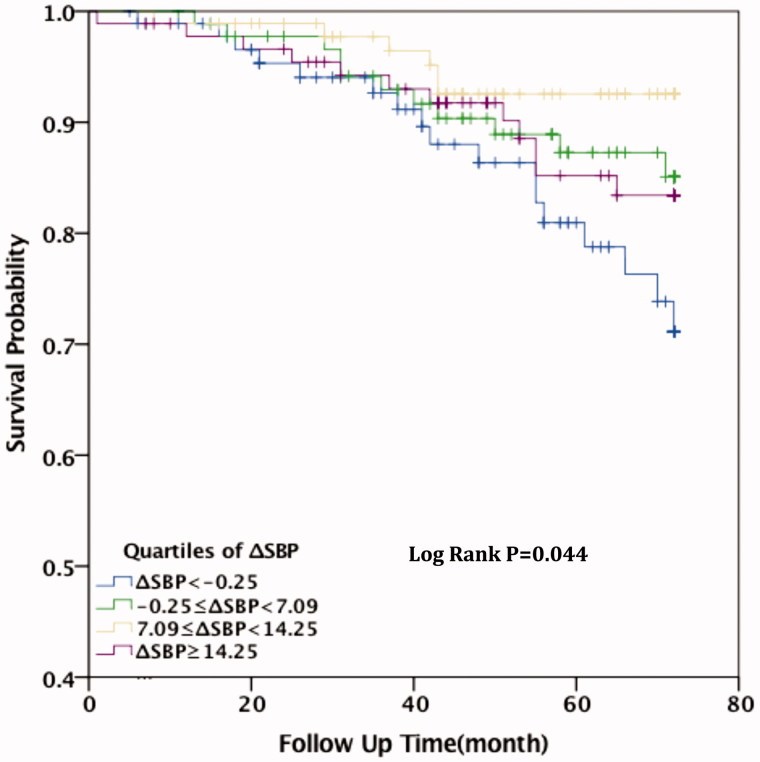
Kaplan–Meier shows the relationship between ΔSBP and all-cause mortality.